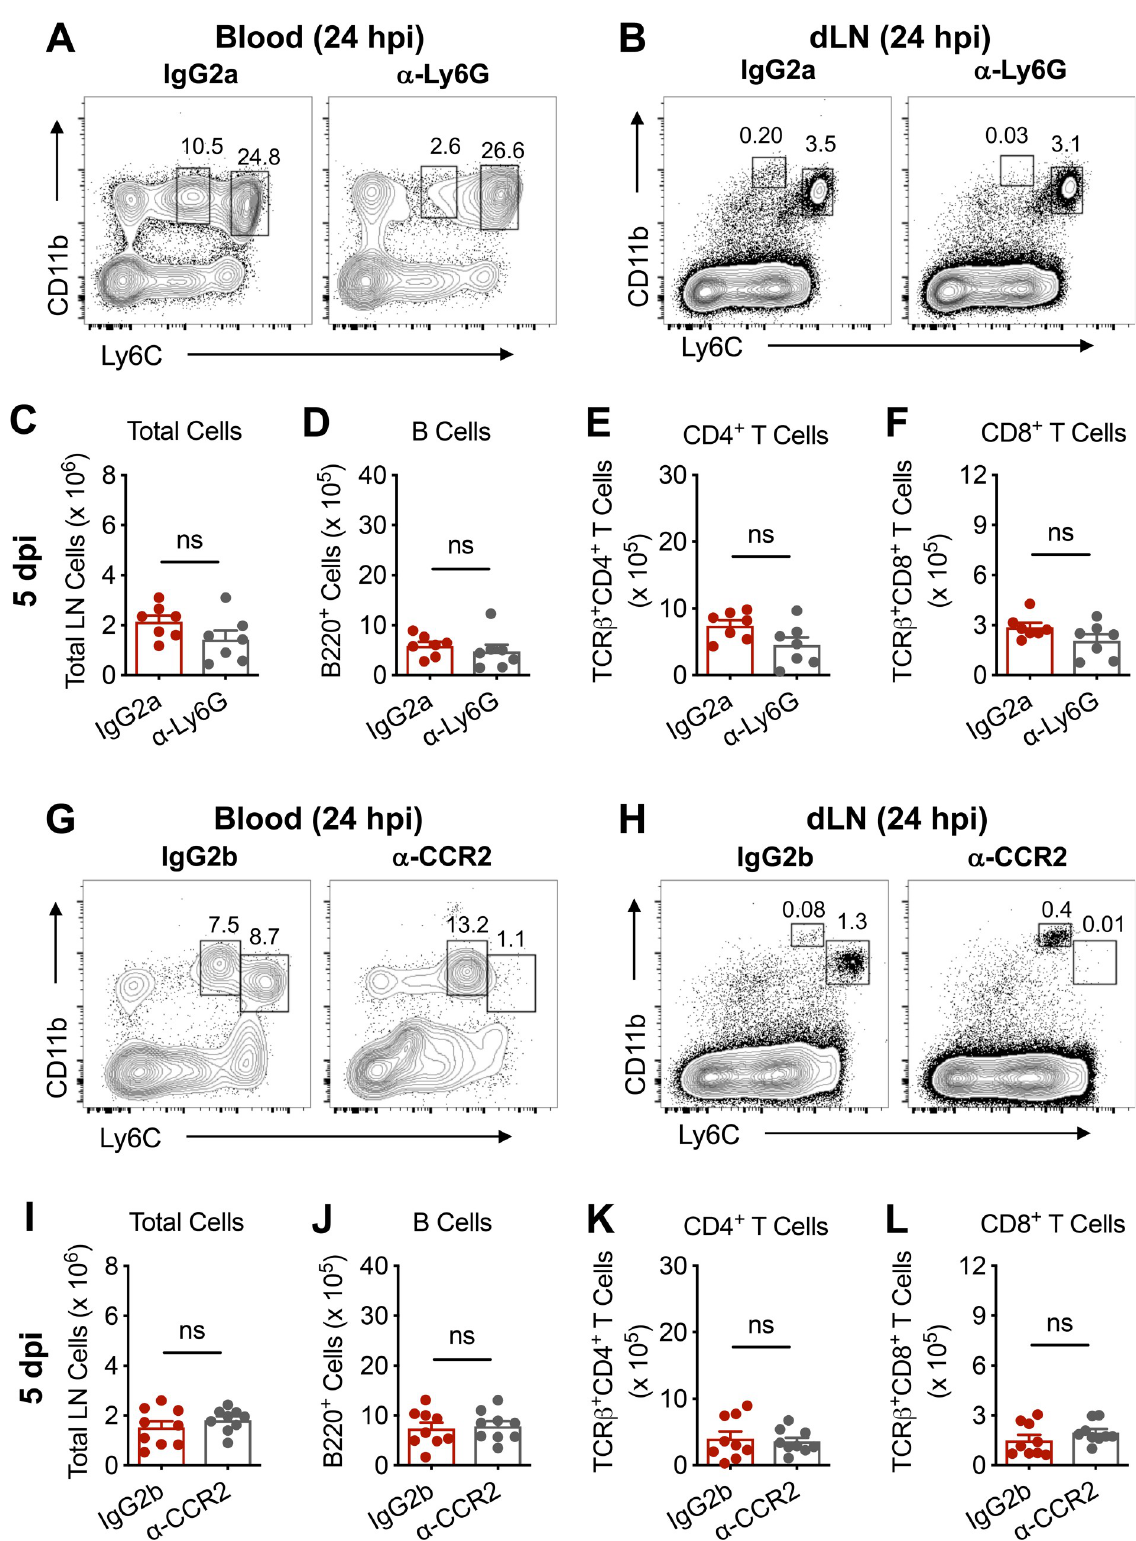
Fig 3. Monocytes or neutrophils prevent lymphocyte accumulation in the dLN during pathogenic CHIKV infection. ( A-F ) C57BL/6 mice were treated with 300 μ g of IgG2a isotype control Ab or anti-Ly6G mAb via intraperitoneal injection one day prior to inoculation with 10 3